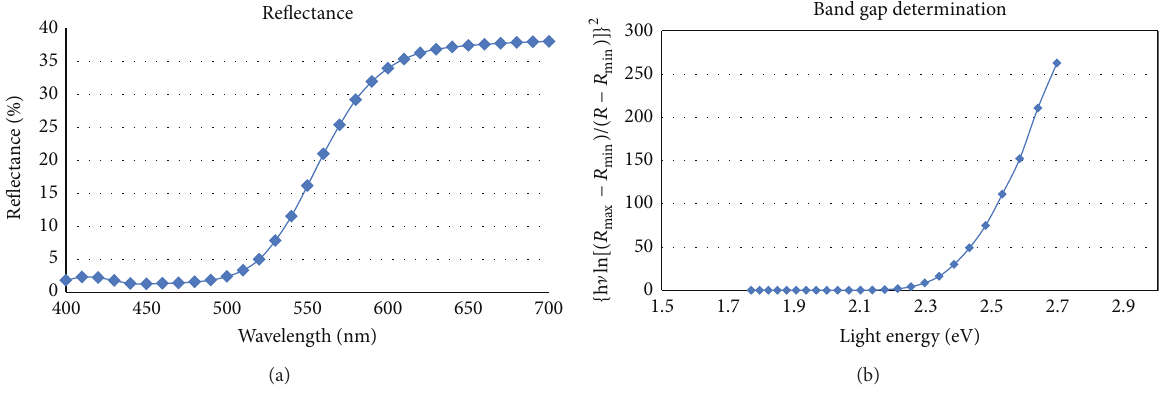
Figure 7: (a) % reflectance against wavelength plot and (b) {ℎ V ln [(𝑅 max − 𝑅 min )/(𝑅 − 𝑅 min )]} 2 versus ℎ V